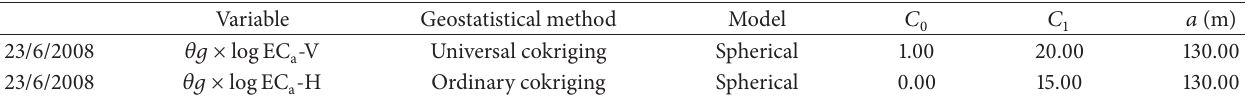
Table 6: Fitted cross-semivariogram models and respective parameters between gravimetric water content (principal variable) and log EC (secondary variable).